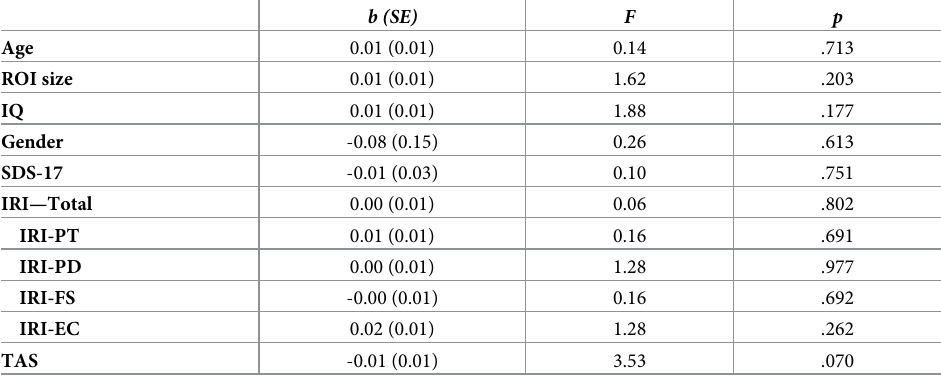
Table 2. Prediction of sociomoral maturity by control variables using linear mixed regressions. b (SE)